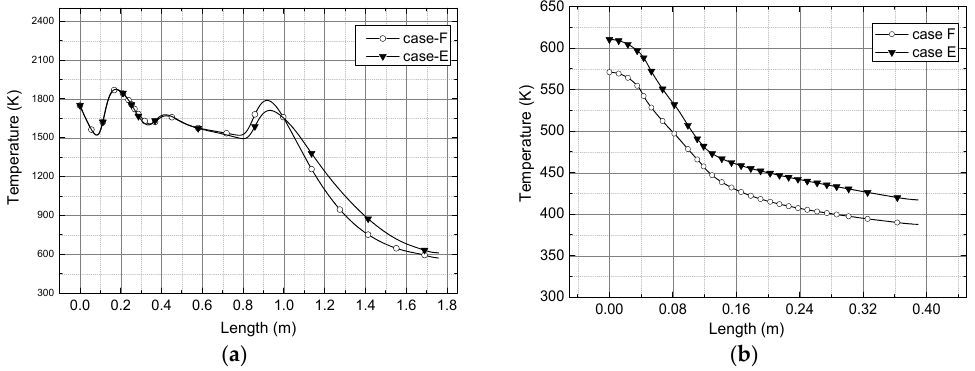
Figure 16. ( a ) Temperature of axial gas stream; ( b ) Temperature of monitoring line.